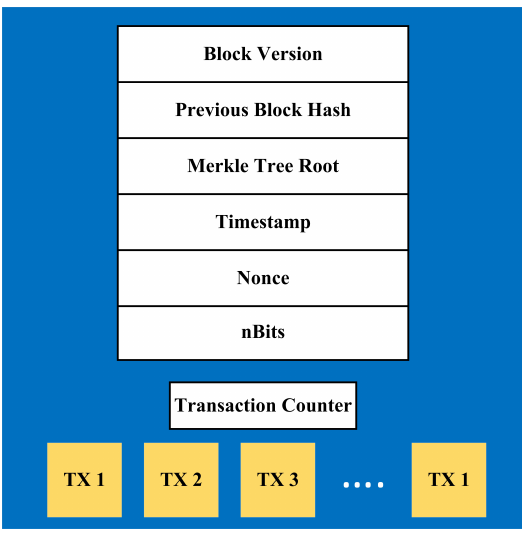
Figure 3. Block header